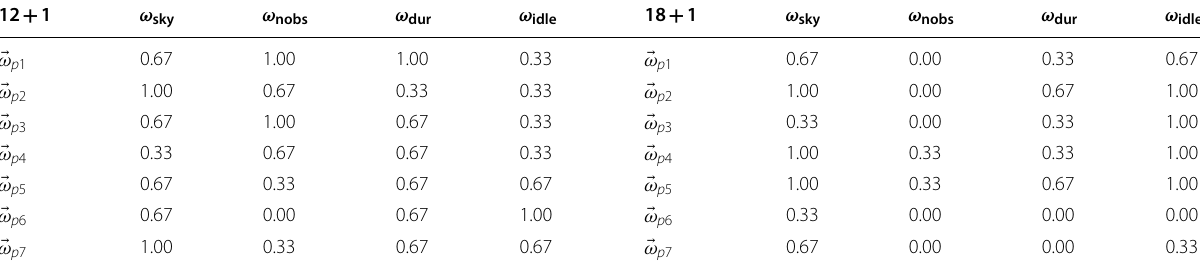
Each row corresponds to one combination of weight factors (cid:31) ω leading to the best result for a network with the additional antenna located at position p 1– p 7 (see Fig. 2)